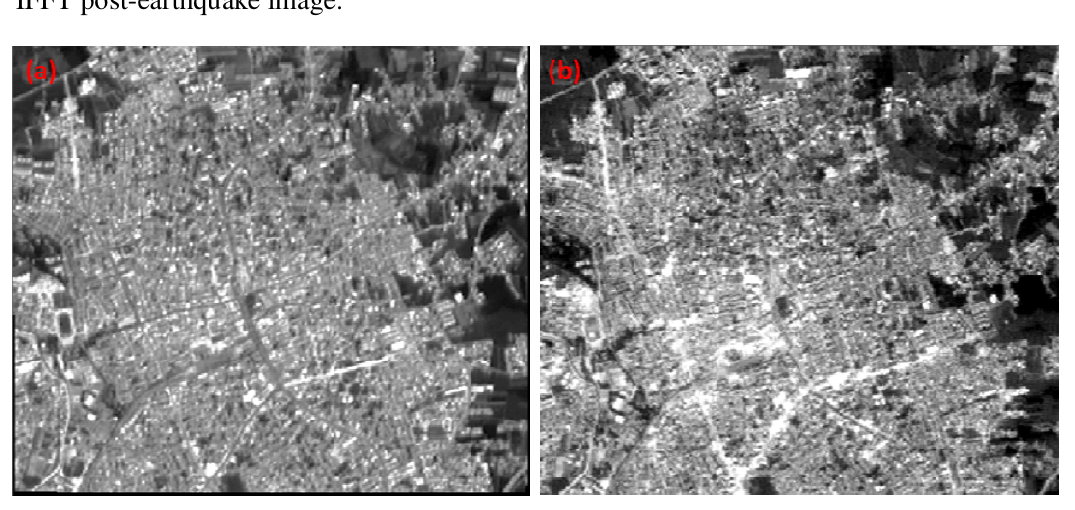
Figure 4 . (a) Original pre-earthquake data, (b) original post-earthquake data, (c) FFT pre- earthquake image, (d) FFT post-earthquake image, (c) IFFT pre-earthquake image, (d) IFFT post-earthquake